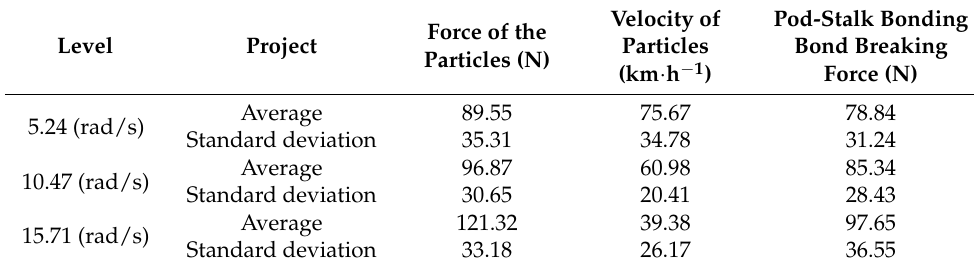
Table 7. Simulation results in different concave plate speed.